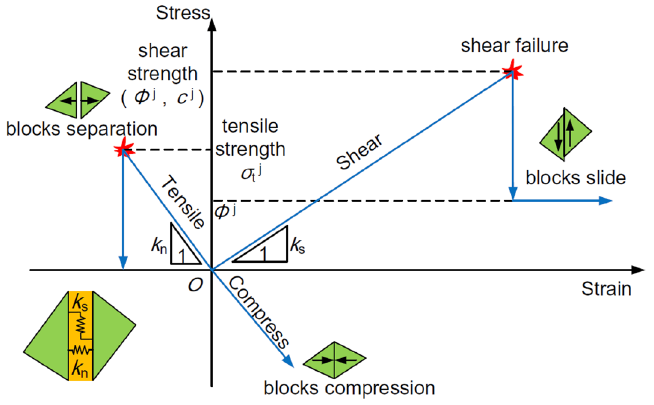
Figure 8. Constitutive behaviour of the